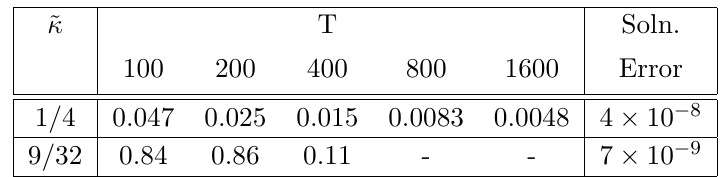
Figure 12 . Left: mLCE for the deformed SU (3) Landau-Lifshitz model with ˜ β = 0 and w φ = w ϕ = α = 1 but different ˜ κ for the initial conditions p θ (0) = 3 / 10 , p ψ (0) = 11 / 10 , θ (0) = 1 and a range of ψ (0) . Right: mLCE for with ˜ β = 0 and p θ (0) = 3 / 10 , p ψ (0) = 11 / 10 , θ (0) = 1 , ψ (0) = 1 / 5 and different parameter values.